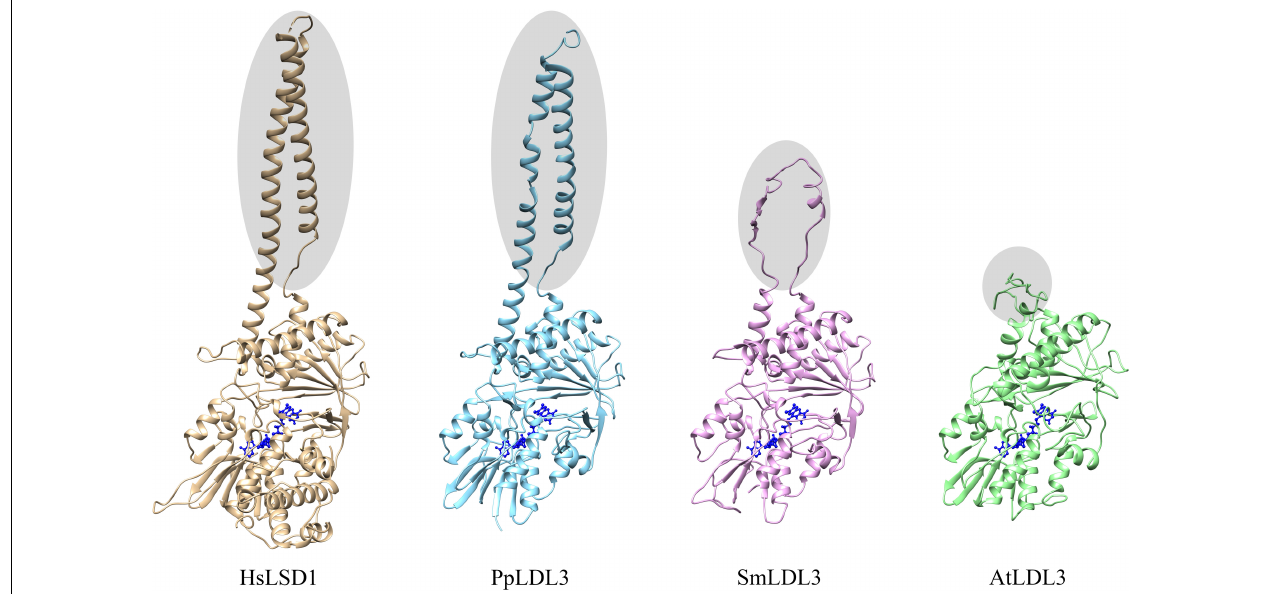
FIGURE 2 | Schematic representation of the three-dimensional structure of human LSD1, Arabidopsis LDL3, as well as Physcomitrella patens and Selaginella moellendorffii LDL3 homologs. The three-dimensional structure of human LSD1 (HsLSD1) is that determined by Forneris et al. (2007) in complex with substrate-like peptide inhibitor. The three-dimensional structure of Arabidopsis LDL3, as well as of Physcomitrella and Selaginella LDL3 homologs (AtLDL3, PpLDL3, SmLDL3, respectively) were obtained through molecular modeling approaches based on the three-dimensional structure of HsLDS1 and the molecular model of Arabidopsis LDL1 (Spedaletti et al., 2008). The FAD cofactor is shown in ball-and-stick representation and colored in blue. Shaded ellipses highlight the ‘Tower’ domain of HsLSD1 and PpLDL3, and the corresponding regions in SmLDL3 and